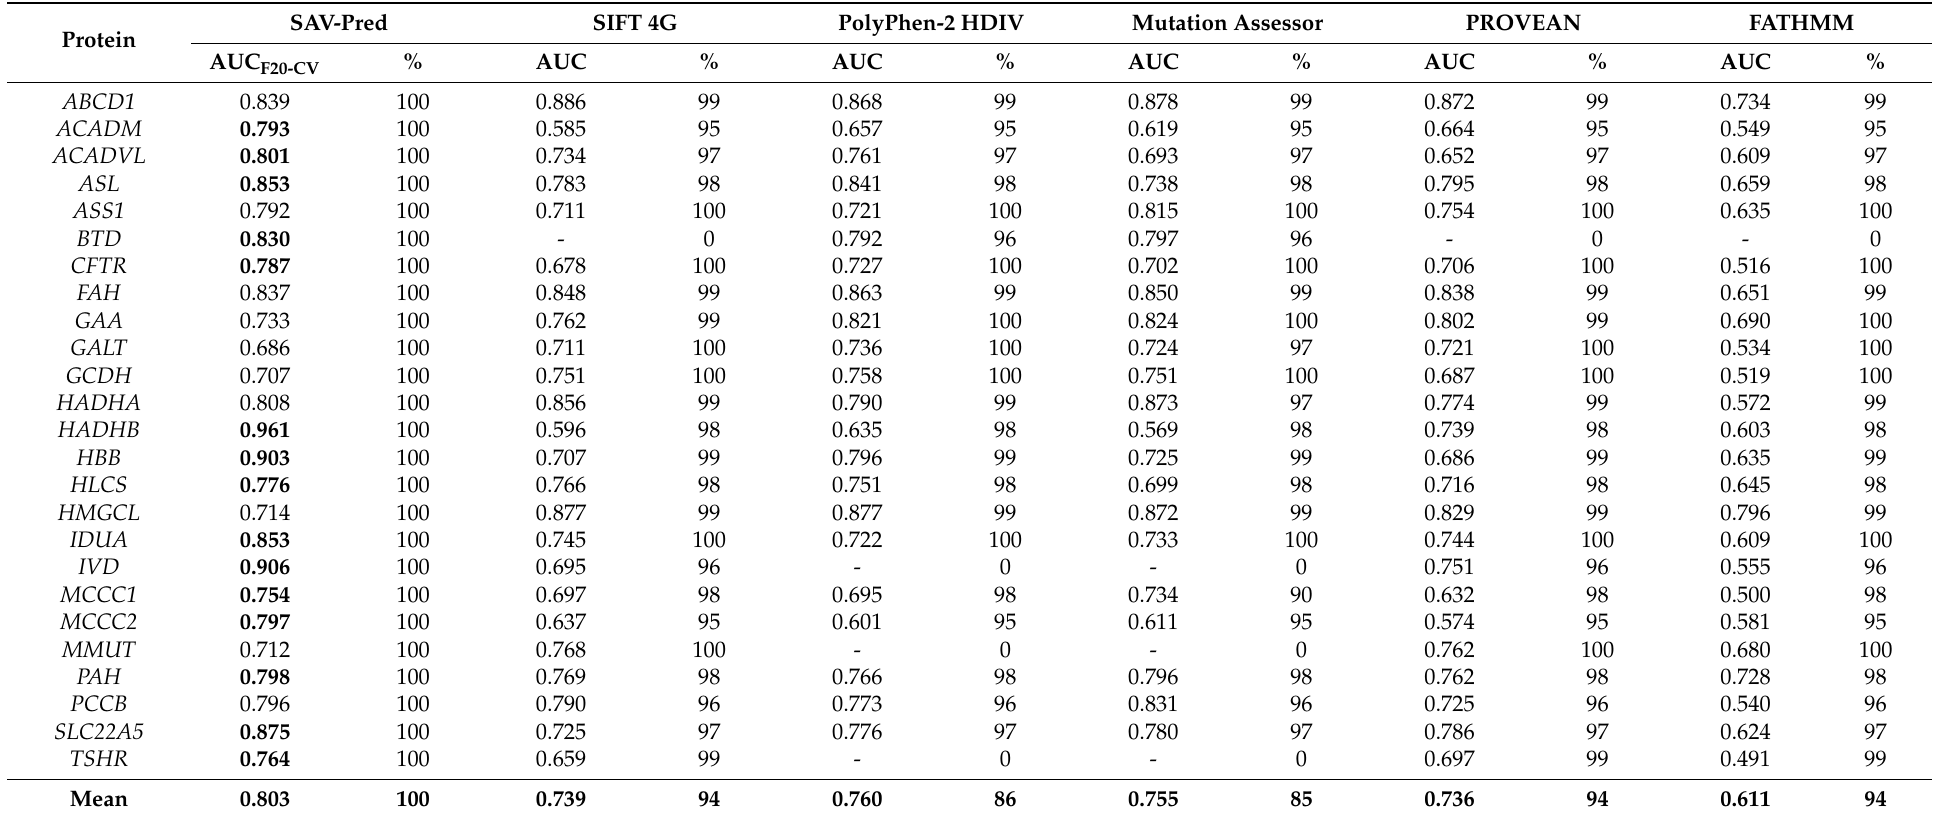
Table 2. Accuracy comparison of the tools in predicting single amino acid substitution effects in proteins related to neonatal